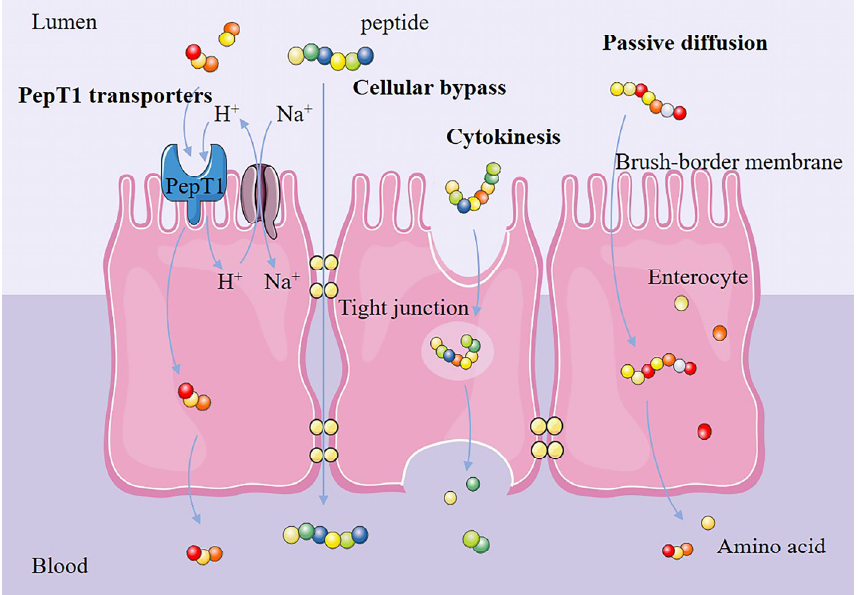
Figure 2. Transport mode of low-molecular-weight, plant-derived bioactive peptides in the intestine. Table 1. Effects of amino acid composition on the anti-inflammatory properties of low-molecular- weight, plant-derived bioactive peptides